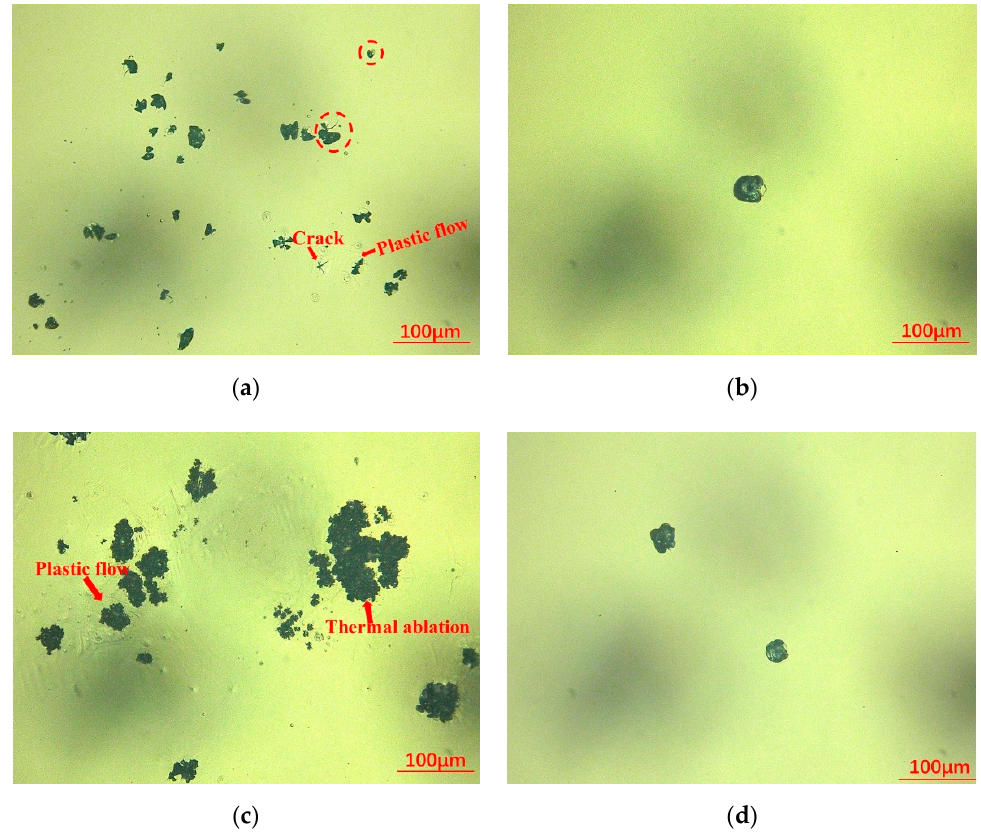
Figure 6. Laser damage morphology results: ( a ) 1—laser damage morphology; ( b ) 2—laser damage morphology; ( c ) 3—laser damage morphology; ( d ) 4—laser damage morphology.